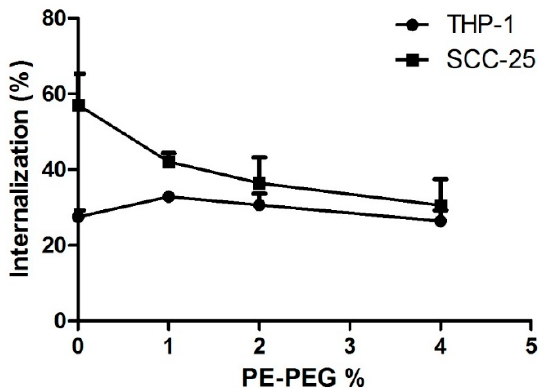
Figure 4. PEG – SLN internalization in different cell lines with ATP depletion treatment. Cells were pre-incubated for 1 h in the presence of 20 mM of sodium azide and 10 mM of 2-deoxyglucose. Then, indicated SLN suspensions were added and cells were further incubated for 1 h. Then, cells were washed and trypan blue was added in order to measure internalized SLN fluorescence. Data are shown as percentage of fSLN internalization relative to the values of internalization in the absence of sodium azide. Results are the mean ± SEM of five independent experiments.